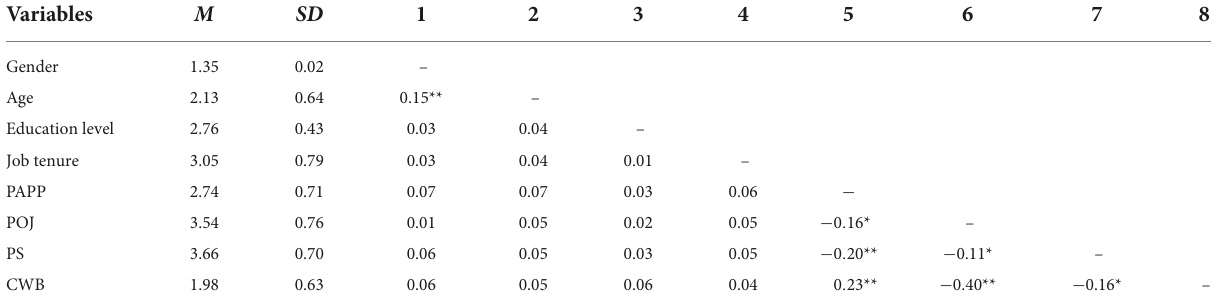
TABLE 3 Descriptive and bivariate correlations